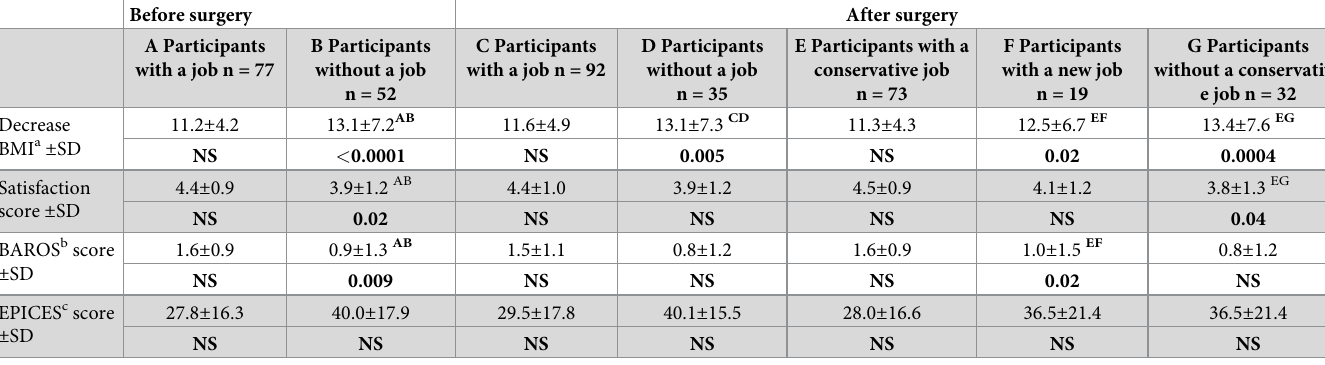
Table 2. Preoperative and postoperative questionnaire scores of groups A, B, C, D, E, F, and G. Before